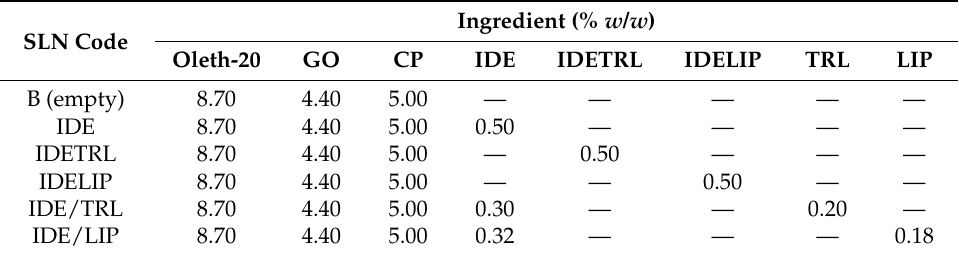
Table 3. Composition of the oil phase of unloaded and drug loaded SLN a